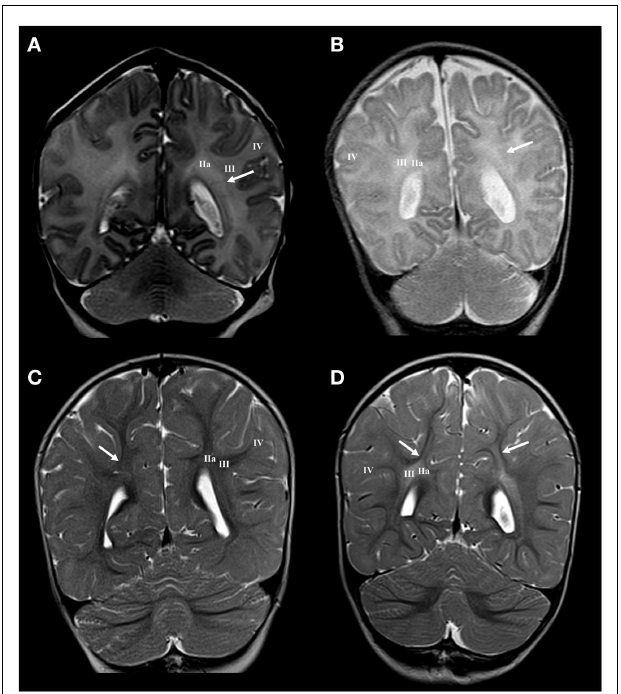
FIGURE 5 | Longitudinal MRI follow-up of perinatal gyral white matter and cerebral cortex lesion on coronalT2 images . Normal findings of gyral white matter and cortex at term age (A) and at the age of 13months (C) . Term born child (BW = 3220g, SNAPII = 31, SNAPEII = 49, AS = 1/3) with perinatal asphyxia and hyperintensity of centrum semiovale and gyral white matter accompanied with cortical lesion at term equivalent age [arrow in (B) ] and with hyper-intensive lesion of gyral white matter and cortex at the age of 13months [arrow in (D) ]. Numbers I–IV represent segments of white matter as previously